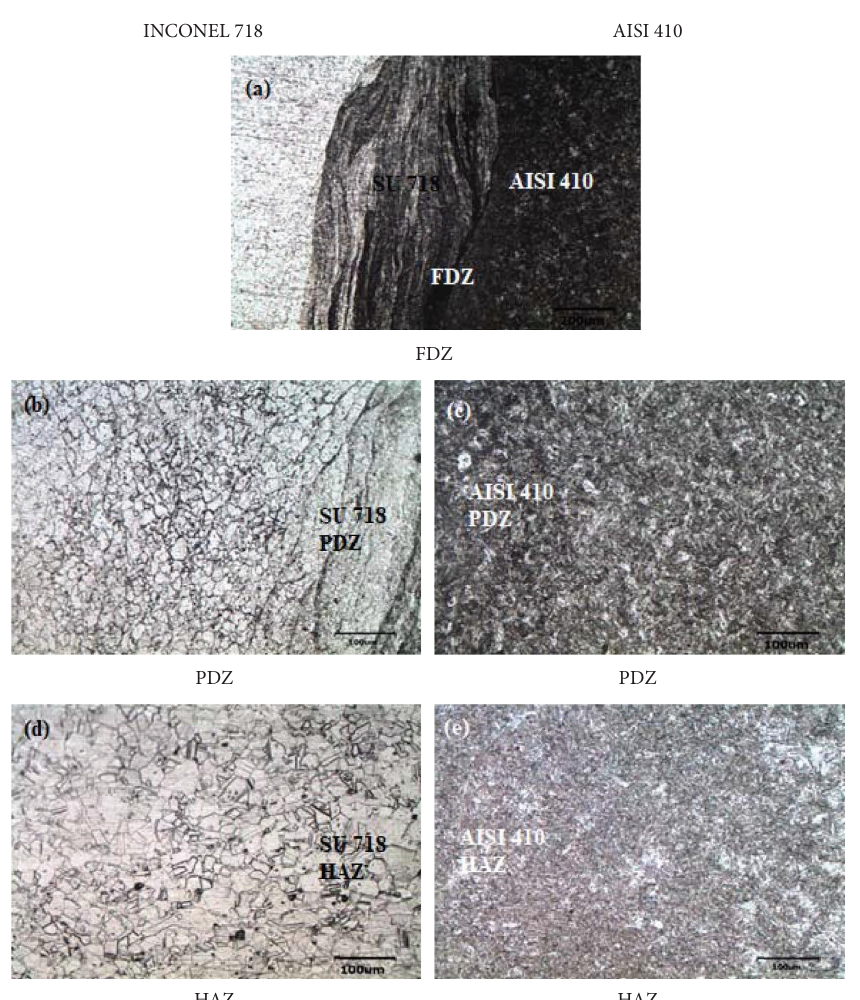
Figure 6: Dissimilar weld joint microstructure at